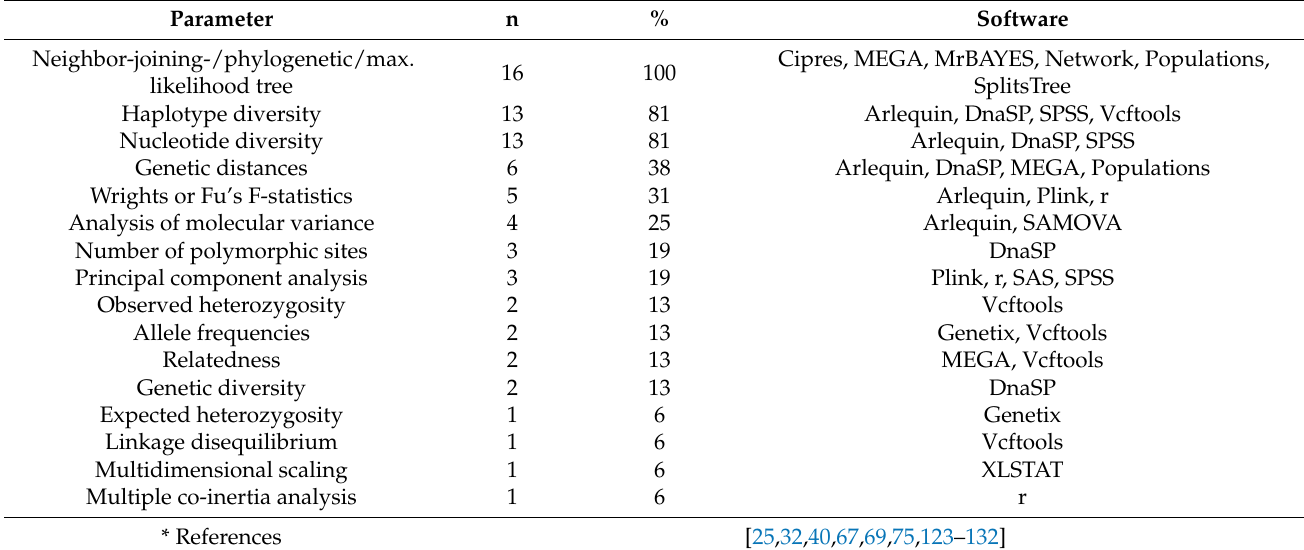
Table 3. Percentage of computed diversity parameters in 16 studies * based on mtDNA analysis and respective software programs used (for citations, see Table S2).